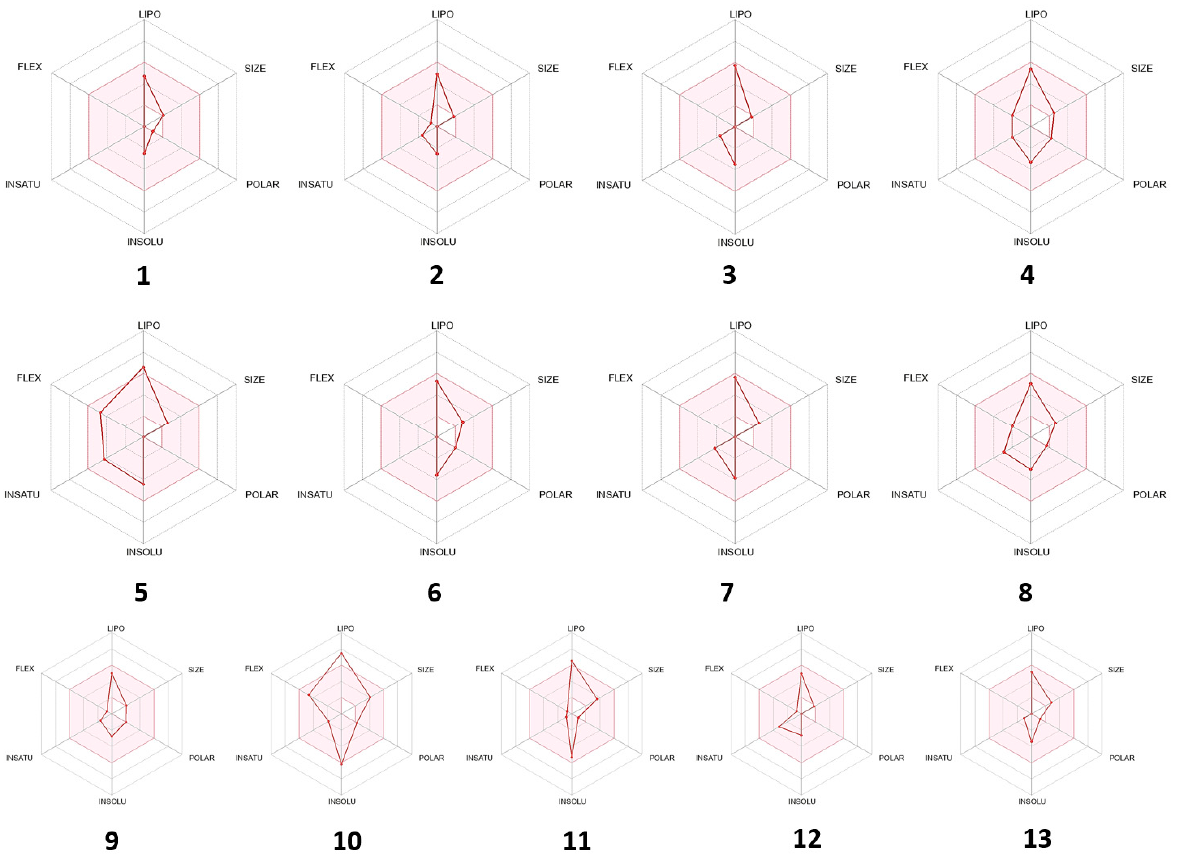
Figure 9. Bioavailability radar of selected phytoconstituents (pink area showed the drug likeness properties of selected compounds) 1: 1,8-cineole, 2: sabinene, 3: α -pinene, 4: α -terpinyl acetate, 5: β -farnesene, 6: viridiflorol, 7: β -caryophyllene, 8: β -iraldiene, 9: terpine-4-ol, 10: 5-(1-isopropenyl-4,5-dimethylbicyclo[4.3.0]nonan-5-yl)-3-methyl-2-pentenol acetate, 11: 13-epimanoyl oxide, 12: α -phellandrene, 13: caryophyllene oxide.